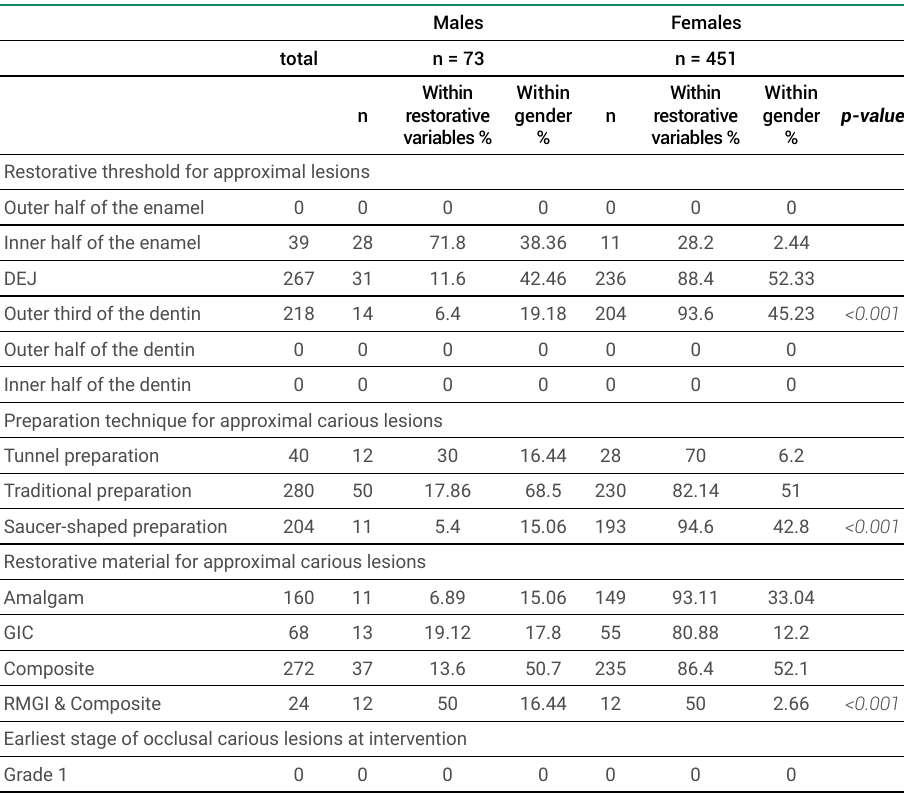
Table 2. Association between years of experience and restorative variables